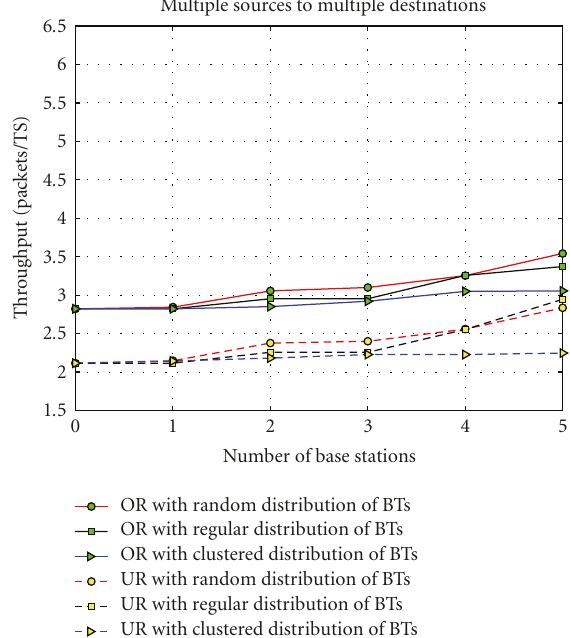
Figure 5: Throughput bound on di ff erent distribution patterns of single-channel